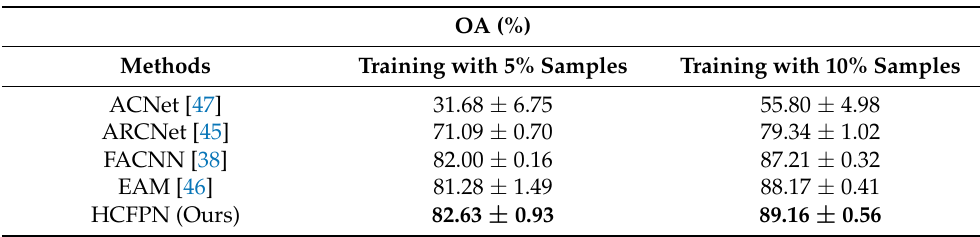
Table 1. Overall accuracy (%) of HCFPN and the comparison methods when trained on the AID dataset using a proportion of 5% and 10% of the samples.